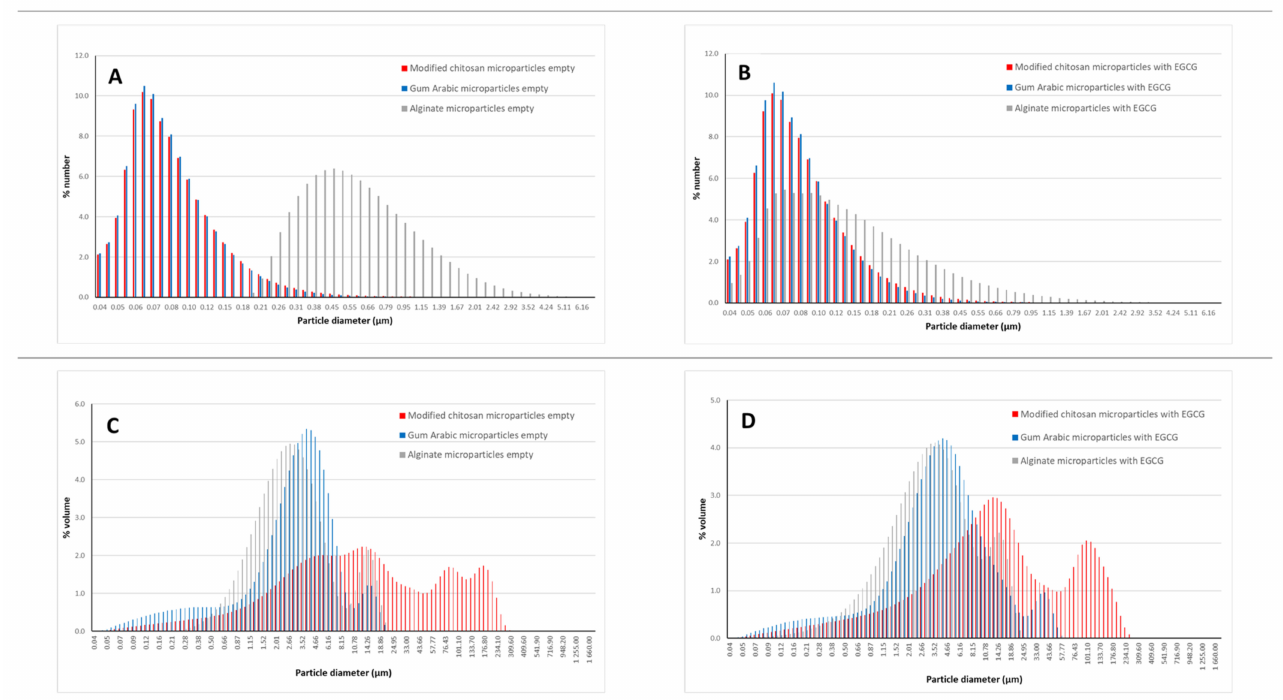
Figure 3. Size distribution considering a number distribution ( A , B ) and volume distribution ( C , D ) of the empty microparticles ( A – C ) and EGCG microparticles ( B – D